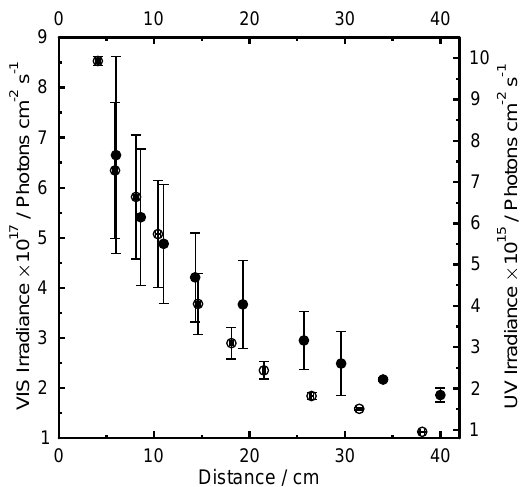
Fig. 2. Spectral irradiance of the VIS and UV irradiation sources used in this study are presented as red and blue lines, respectively. The black line indicates the spectral irradiance of the sun.